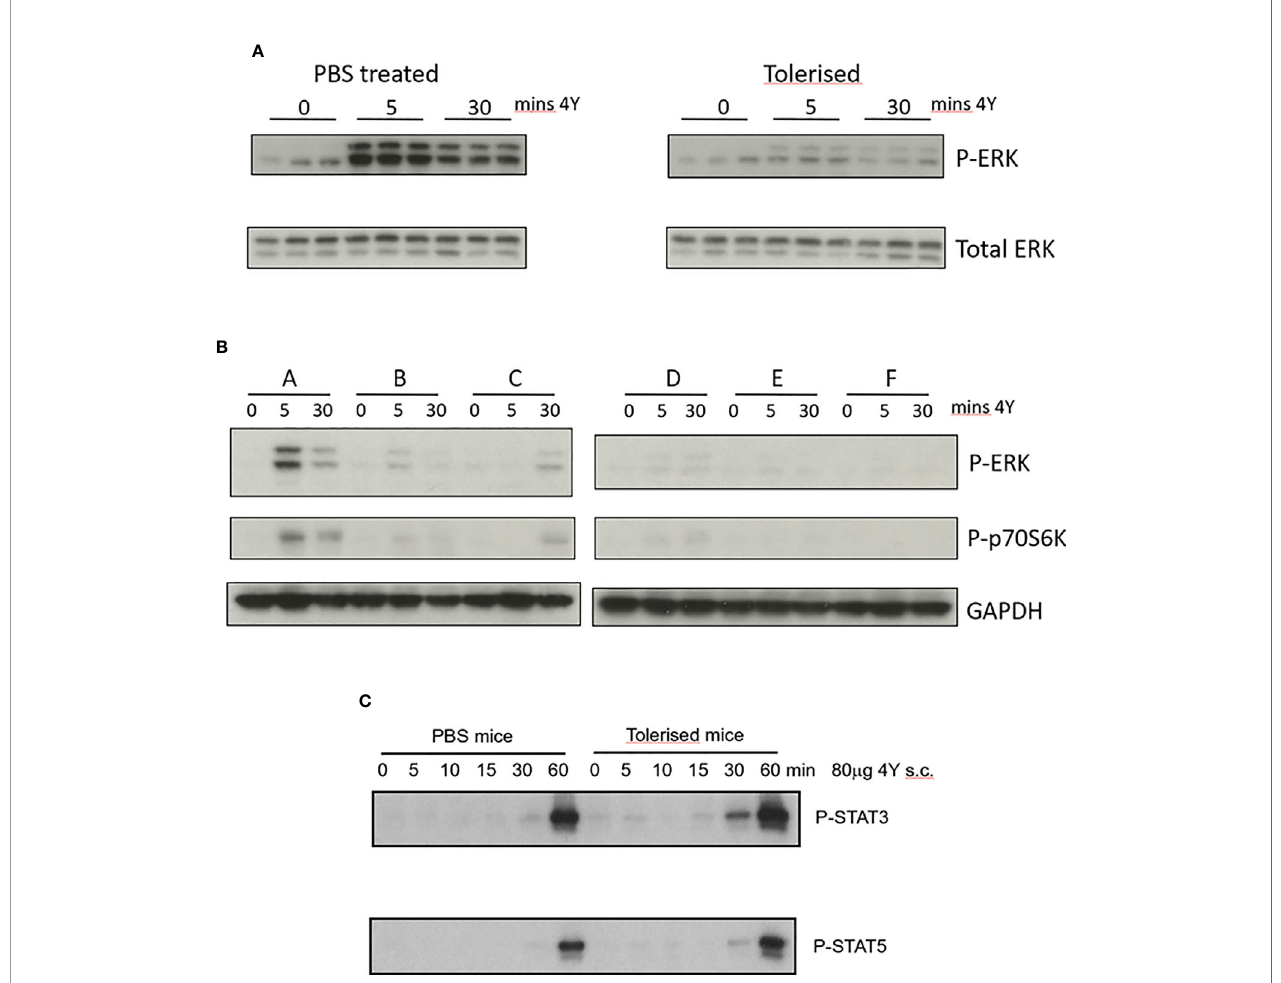
FIGURE 4 | Impact of peptide induced tolerance induction on cell signaling (A) CD4 + T cells were enriched from spleens of naïve (PBS treated) versus tolerized Tg4 mice at the indicated times following challenge with 80µg MBP Ac1-9[4Y] SC, cell extracts prepared and Western blots stained for either phospho-ERK or total ERK protein. (B) CD4 + T cells collected at the indicated time after Tg4 mice were tolerized by dose escalation as shown in Figure 3E . Western blots were stained for phosphor-ERK and phosphor-p70S6K using GAPDH as loading control. (C) CD4 + T cells were enriched from spleens of naïve versus tolerized Tg4 mice at